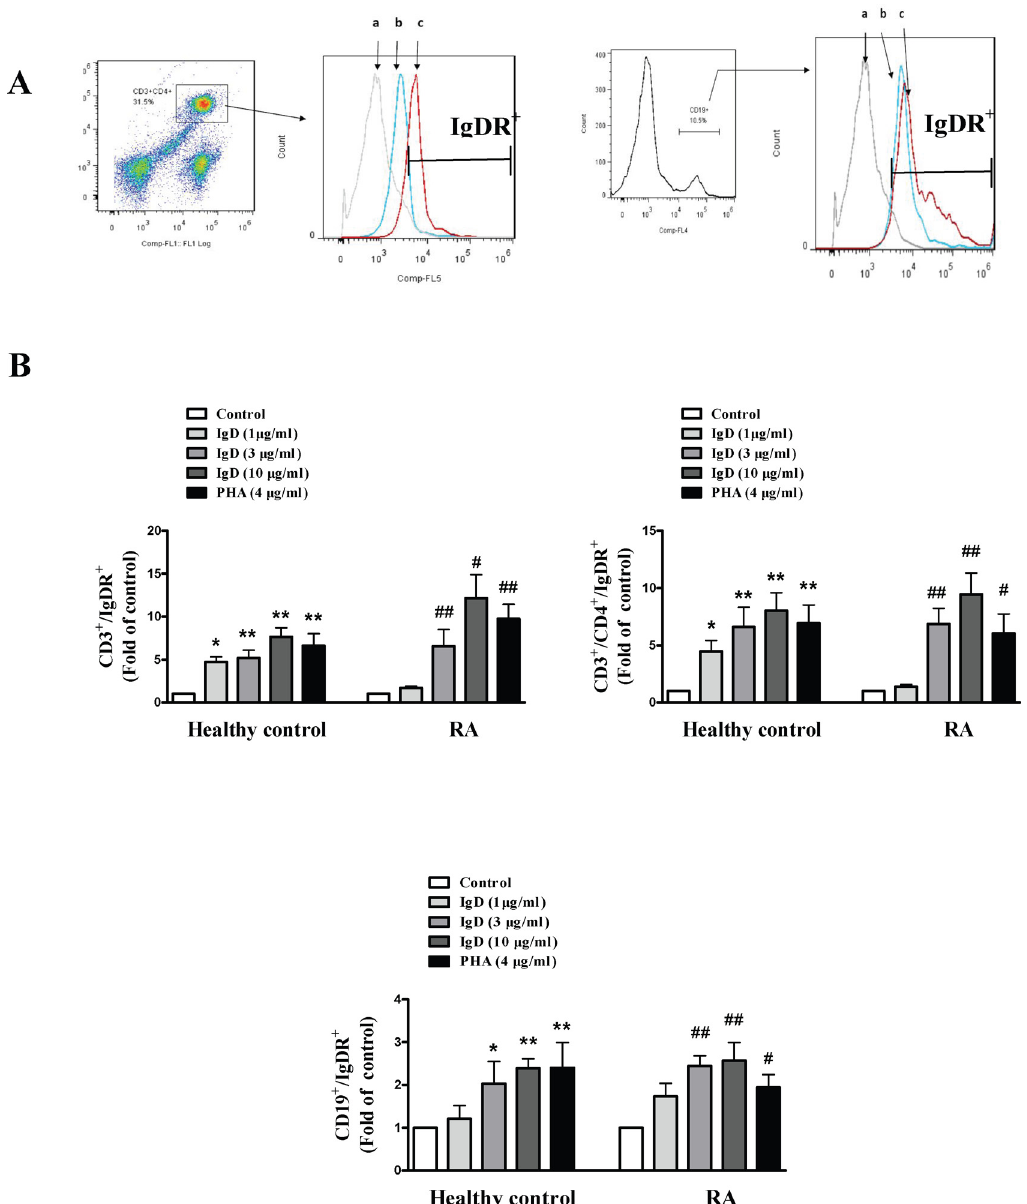
Fig 8. The effects of IgD on IgDR expression in PBMCs from RA patients and healthy controls. (A): A histogram showing the expression of IgDR on CD3 + CD4 + -gated T cells and CD19 + -gated B cells. The fluorescence profile of the stained cells was analyzed by flow cytometry. Curve a: isotype control; curve b: control group; curve c: IgD (10 μ g/ml) group. (B): Effects of IgD treatment (1, 3, or 10 μ g/ml) on the percentages of CD3 + IgDR + T cells, CD3 + CD4 + IgDR + T and CD19 + IgDR + B cells. Data are expressed as the mean ± standard error of the mean (n = 6). * P < 0.05, ** P < 0.01 vs . the control from healthy controls; # P < 0.05, ## P < 0.01 vs . the control from